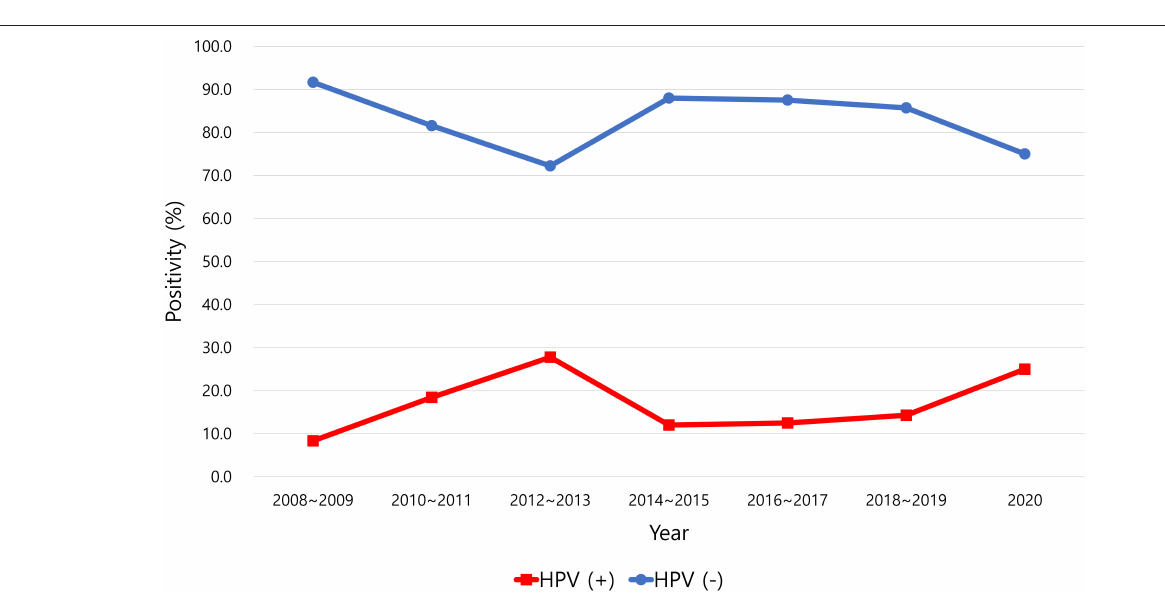
(52%) (31), France [46.5% (32) and 50.4% (33)], and Norway [52% (34) and 77%